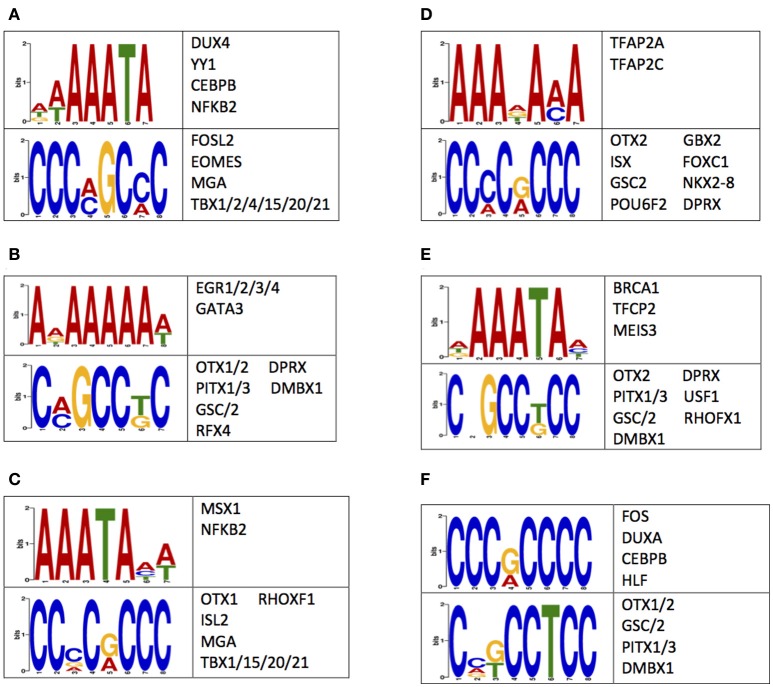
Sequences flanking DMLs and DhMLs contain putative transcription factor binding sites. The logo of enriched motifs found using sequences from (A) all DMLs, (B) human-specific DMLs, (C) monkey-specific DMLs, (D) all DhMLs, (E) human-specific DhMLs, and (F) monkey-specific DhMLs that were predicted by the DREME suite (E < 1e-4) are depicted. A table of transcription factors predicted to bind to these motifs are also shown.